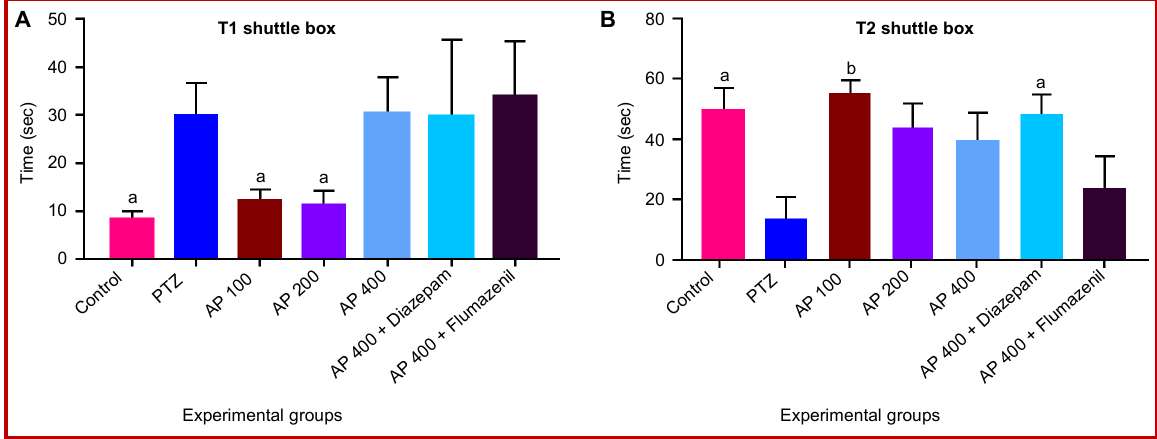
Figure 3: Comparison of initial (A) and secondary (B) latency in passive avoidance memory test between groups; * significant dif- ference compared to pentylenetetrazole group ( a p<0.05, b p<0.01 and c p<0.001); AP = A.